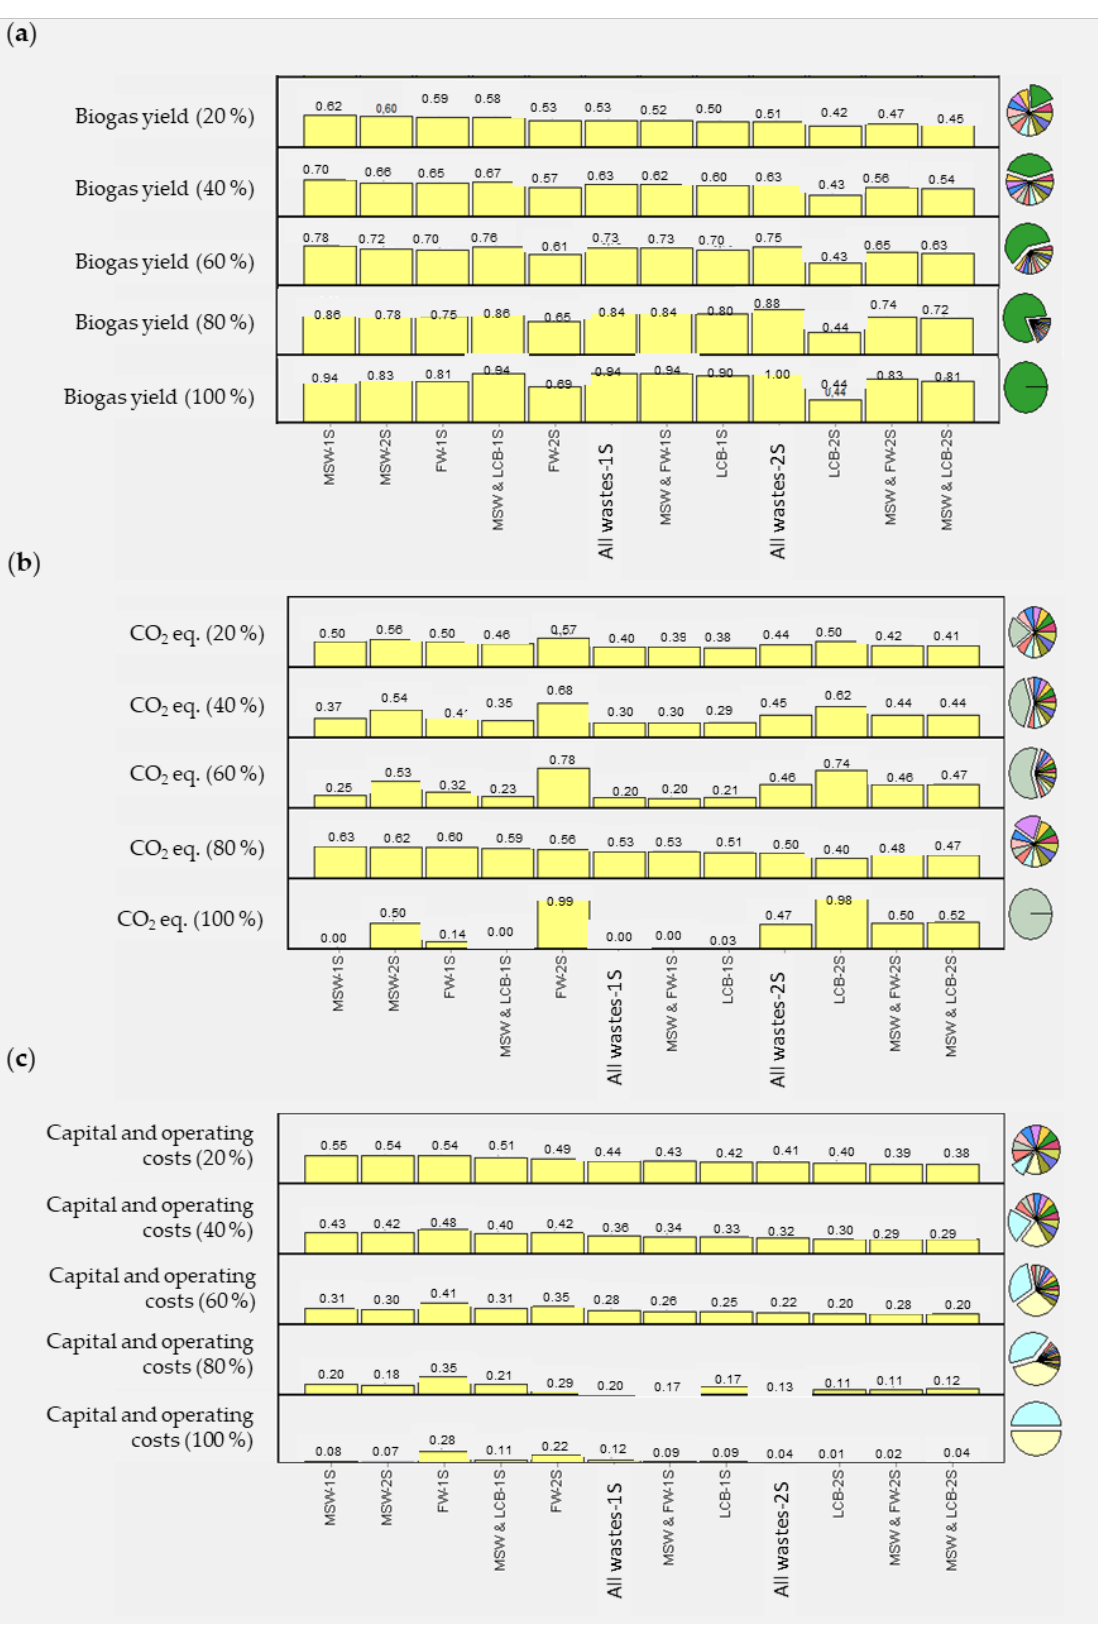
Figure 4. Ranking scores of the biogas plant alternatives from three main perspectives: ( a ) varying the biogas yield from 20% to 100%; ( b ) varying the CO 2 eq. from 20 % to 100 %; ( c ) varying capital and operating costs from 20% to 100%.